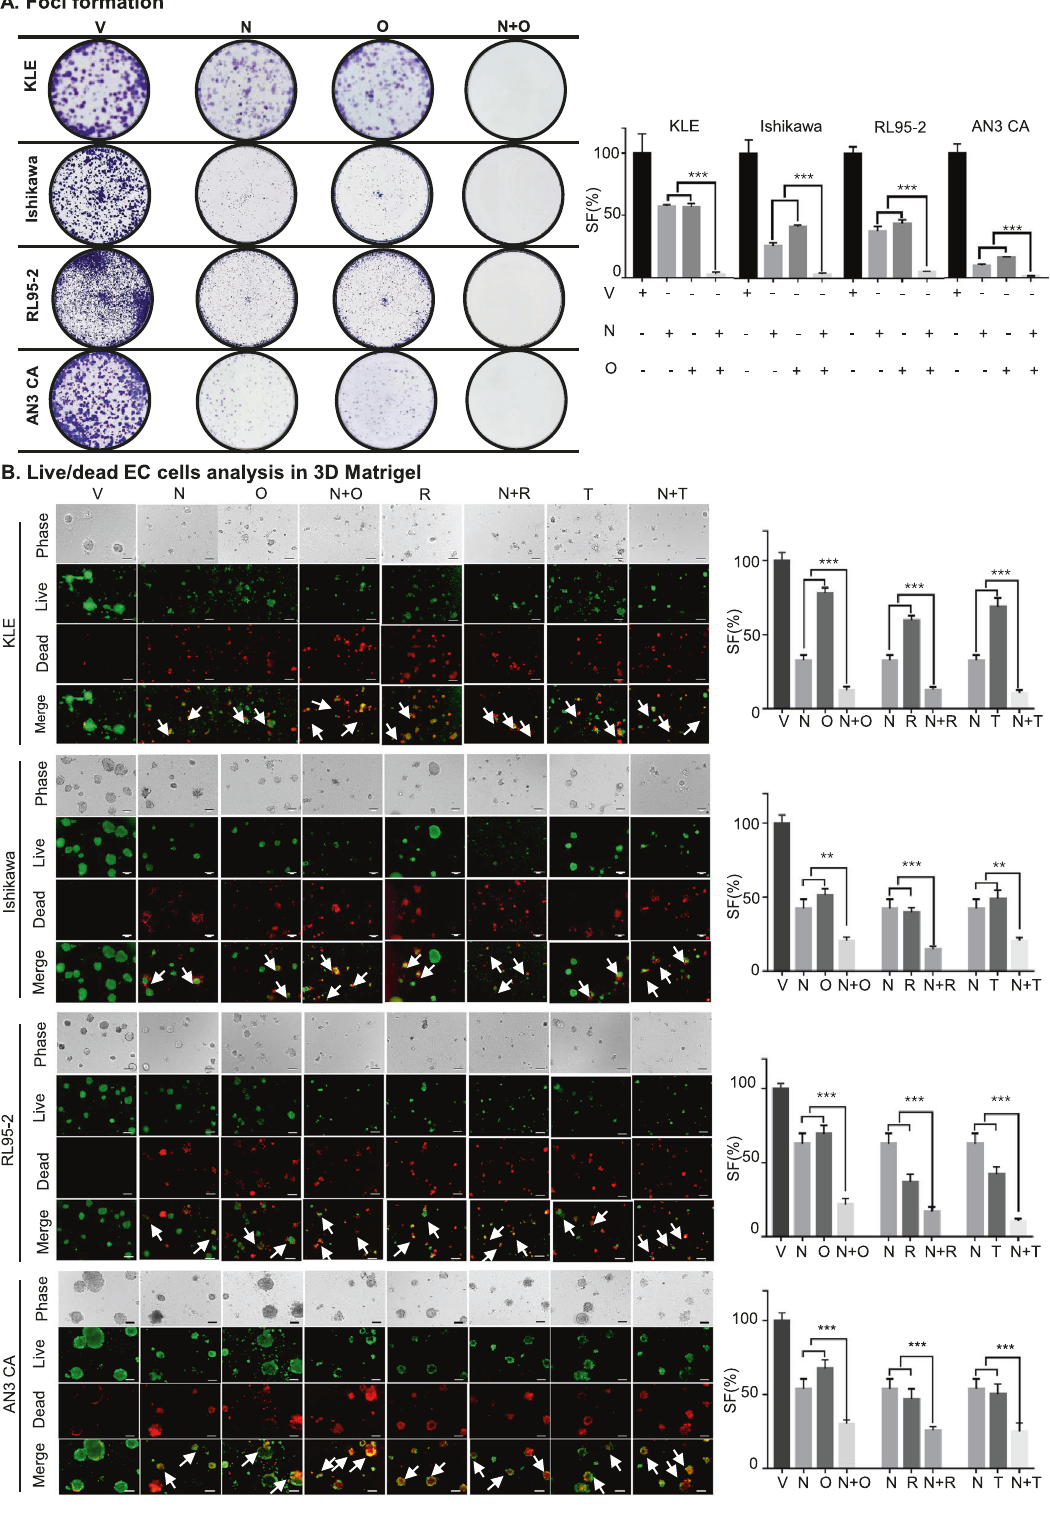
The BCL-2 – associated death promoter (BAD) protein is a BH3-only member of the BCL-2 family of proteins that integrates the common cell survival effects of the PAT and RMM pathways [31, 32]. Human (h) BAD is phosphorylated (p) at Serine (S)75 primarily through p44/ 42 MAP kinase pathway activation [33], and at S99 primarily through the activation of AKT/p70S6K [34, 35], although other kinases